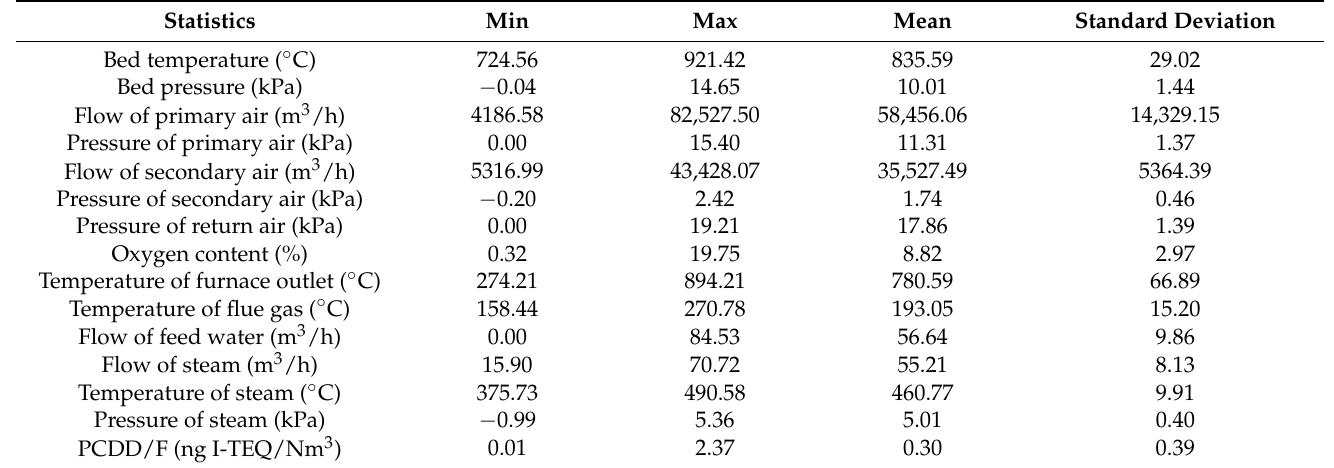
Table 1. Statistics of operating parameters and PCDD/F concentrations.